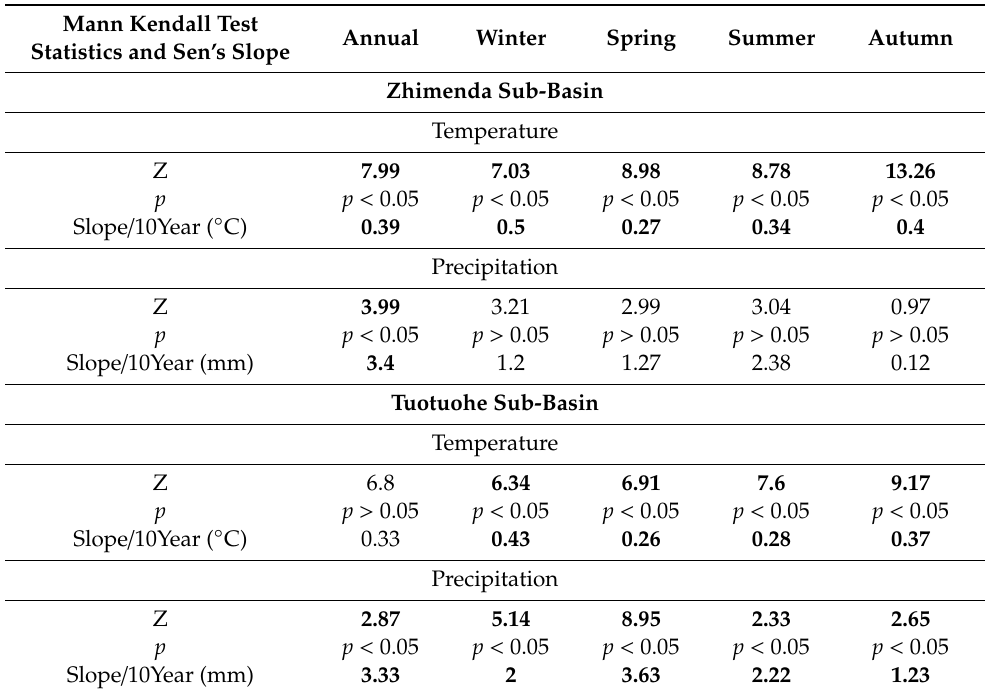
Table 6. Results of annual areal mean precipitation and temperature for each sub-basin for modified Mann–Kendall statistics (Z), both annually and seasonally. Bold values show statistically significant trends at a 0.05 significant level.